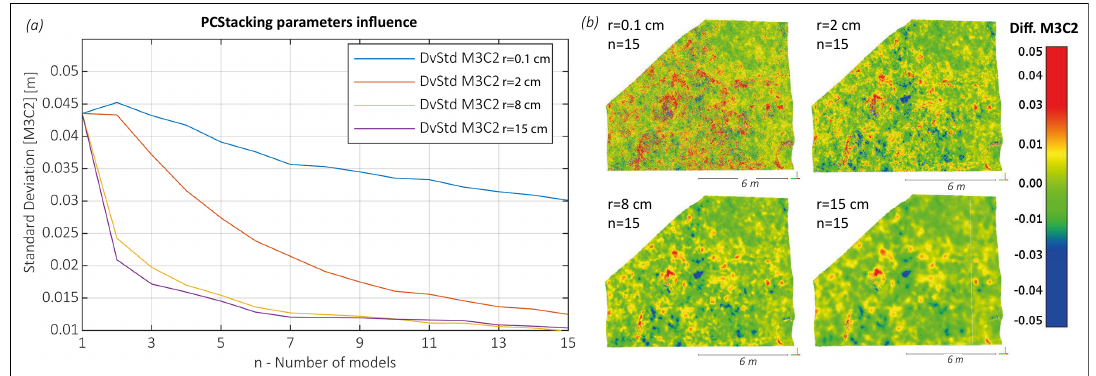
Figure 10. Influence of the search radius (r) on the PCStacking results. ( a ) Standard deviation of the Enh-PC n25 feb vs. Enh-PC n26 feb comparison. ( b ) Comparisons between Enh-PC 1525 feb and Enh-PC 1526 feb for di ff erent search radii